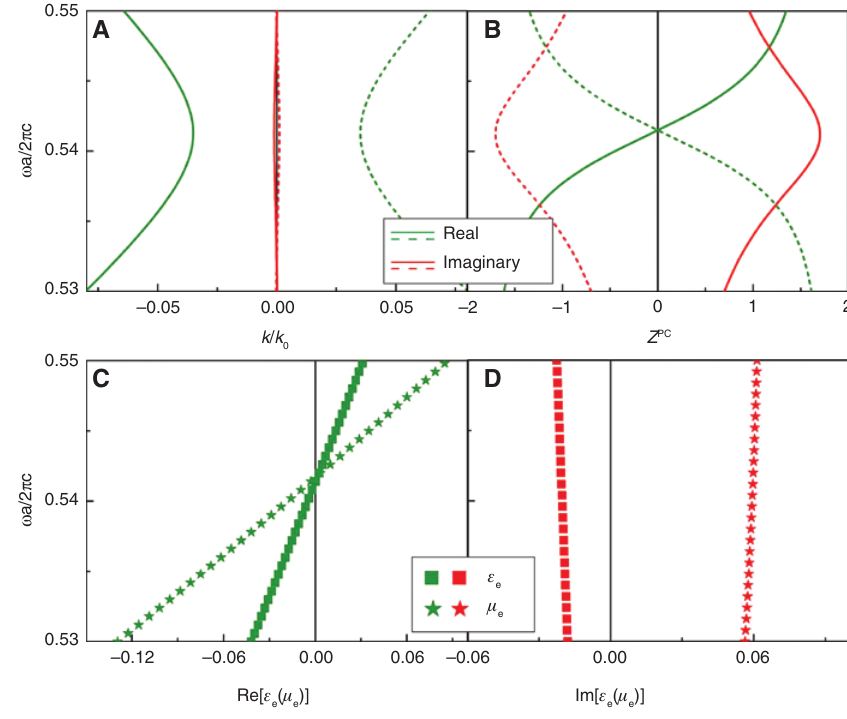
Figure 3: Effective parameters obtained from the real spectra as shown in Figure 2. (A) Complex-valued k ( ω )/ k band and (B) averaged field ratio Z PC calculated numerically from COMSOL. Bands with positive and negative 0 wave vectors are represented by dashed and solid lines, respectively. The real (green) and imaginary (red) parts of the effective parameters ε and μ are plotted in squares and stars, respectively (C and e e